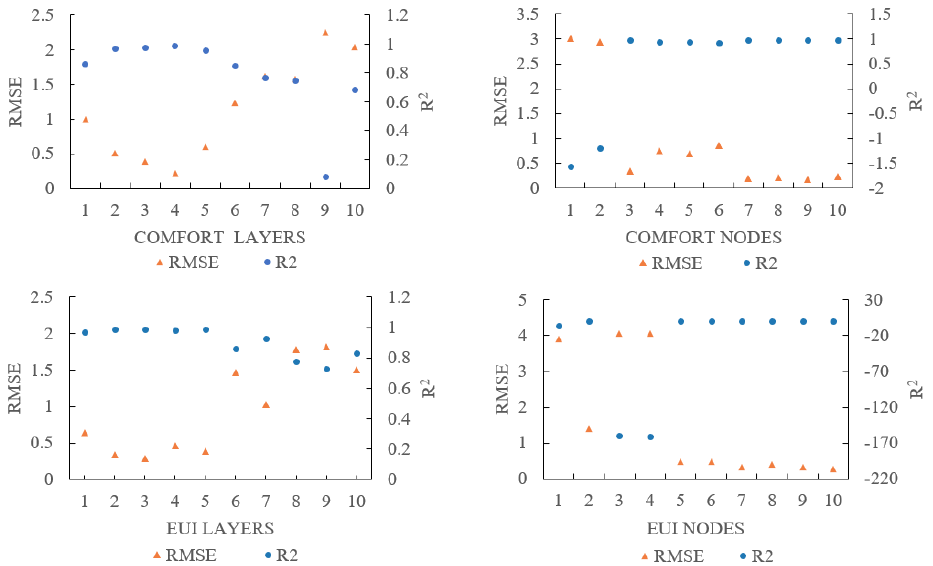
Figure 13. Test map of hidden layer and number of neurons. Table 6. Accuracy comparison of machine learning methods.